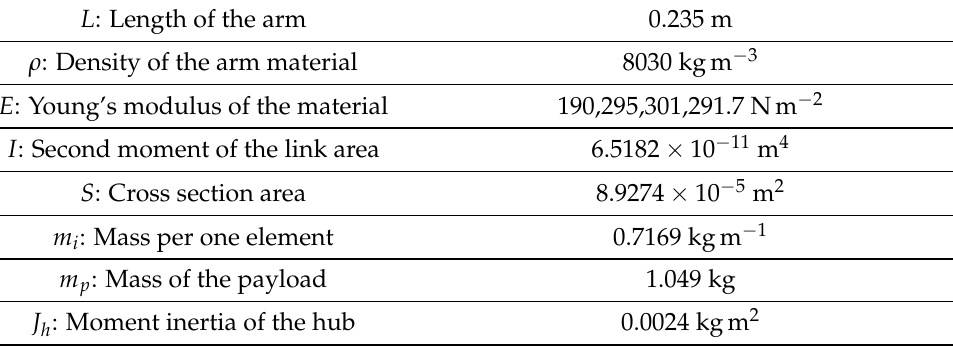
Table 2. Mechanical parameters of the flexible arm motion